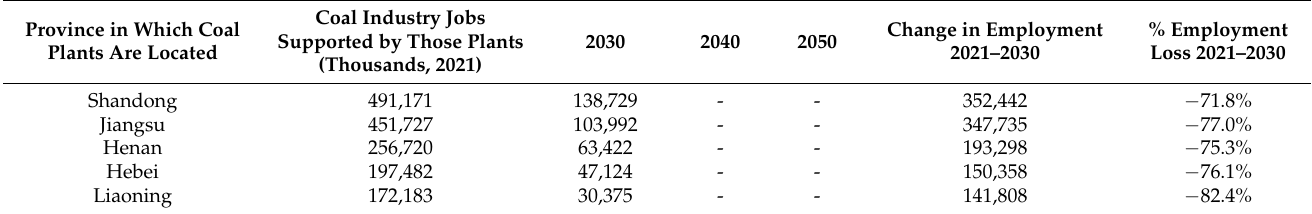
Table A5. Trends in coal industry employment supported by each province, 2021–2060 and change to 2030 (C50